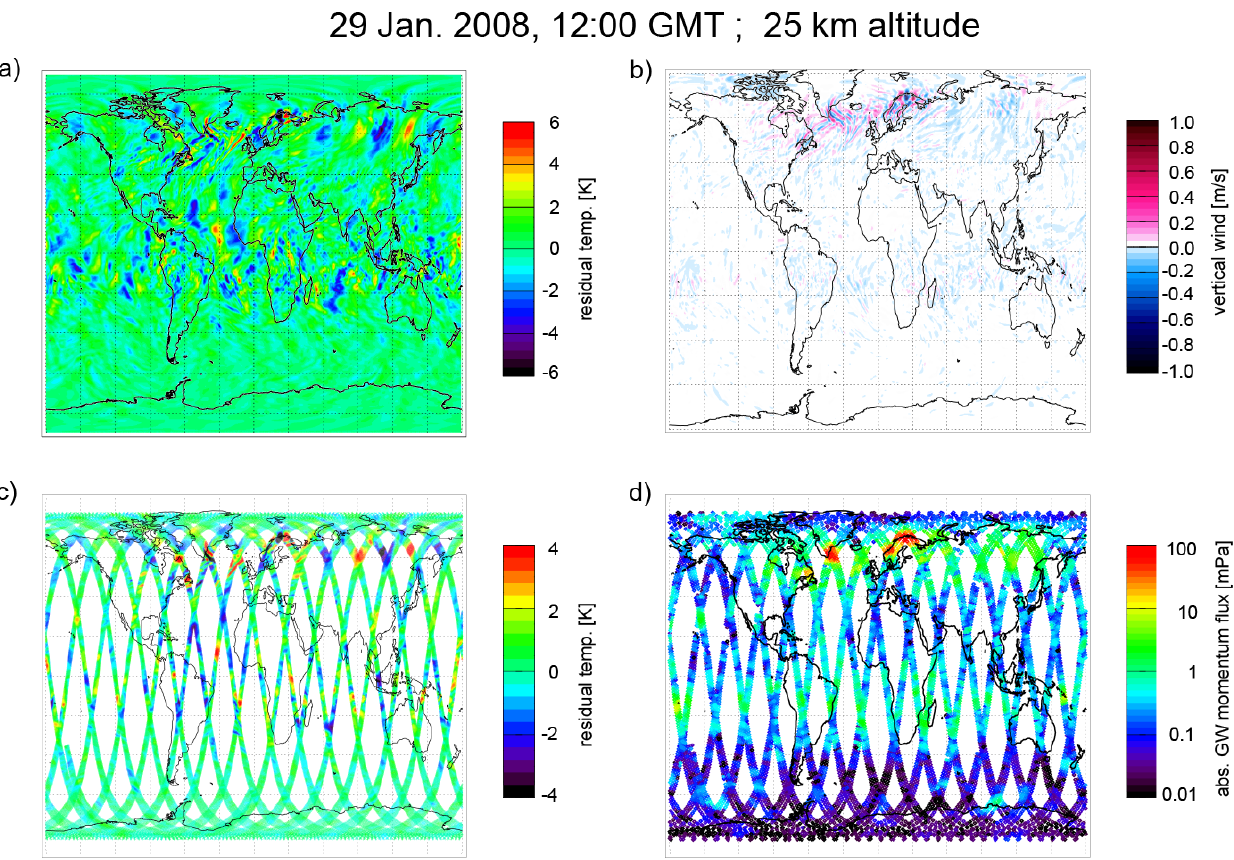
Figure 2. Gravity wave parameters in ECMWF reanalysis fields. Panel a shows temperature residuals from black, − 6K to red, 6K after removing the zonal mean and planetary scale waves up to wave-number 6. Vertical winds (blue, − 1ms − 1 to red, + 1ms − 1 ) in (b) highlight the small-scale structures. For satellite-like processing the residual temperatures (black, less-equal than − 4K to red, larger-equal 4K) are sampled to simulated measurement positions of an ILI in (c) . After applying a limited-volume three-dimensional sinusoidal fit, GW momen- tum flux (black, less-equal 0.01mPa to larger-equal 100mPa) is deduced (d) . GWMF is largest in regions of strong vertical wind structures (b) and where temperature residuals indicate large amplitudes of short horizontal scales (a, c)